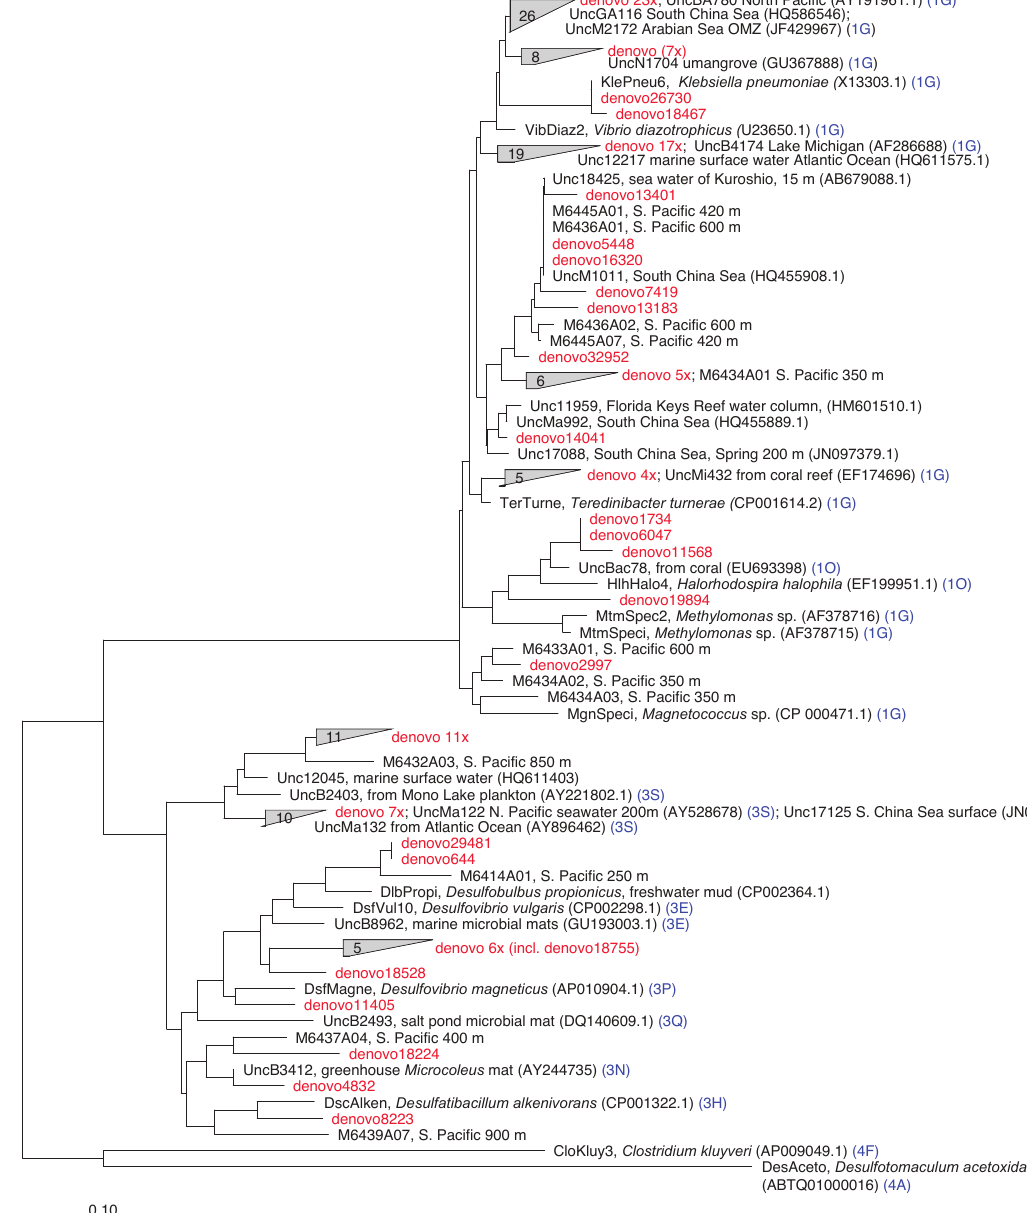
Figure 4. The nifH amino acid neighbor-joining tree with the 100 most abundant OTUs from this study. Sequences beginning with “denovo”, shown in red, are randomly chosen representative sequences from these OTUs (OTUs binned at 97% identity). The clusters in the tree are grouped at an approximately >95% sequence identity. The tree includes reference sequences (if uncultivated, the names of these sequences start with “Unc”). The reference sequences are shown with accession numbers from the nifH database and with the cluster identifier shown in blue if indicated in the nifH database. Additional sequences are included from a previous study in the South Pacific mesopelagic layers (Benavides et al., 2015); these clones are labeled with the original clone names M64XXAXX and